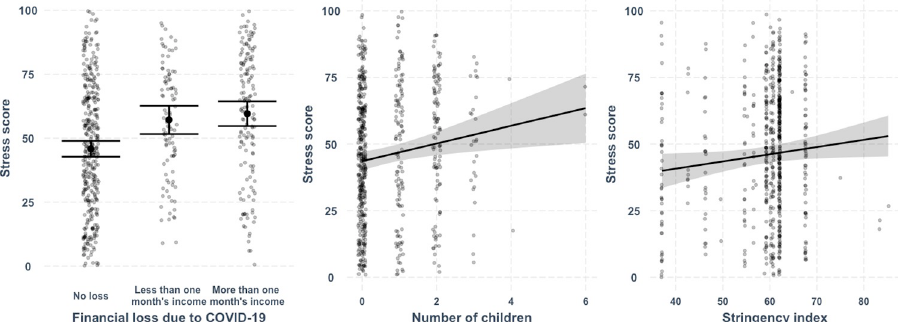
Fig 2. Predicted values of the stress score for different values of financial loss, number of children, and stringency index. 95% confidence intervals are shown for predicted values where all other predictors are held constant, i.e., their mean values are used. Grey dots display the predicted data with the effects of all other predictors accounted for.